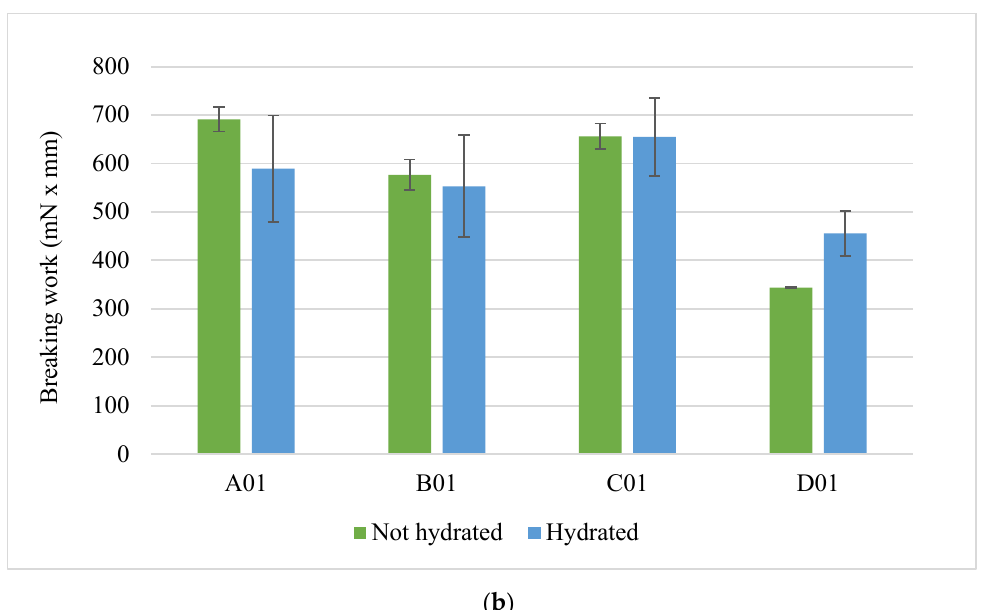
Figure 5. Maximal strength ( a ) and breaking work ( b ) of hydrated and not-hydrated mucin tablets. Tablets that require more work to break the bond between tablet and gel are A01 and C01, both hydrated and not-hydrated (Figure 5b).